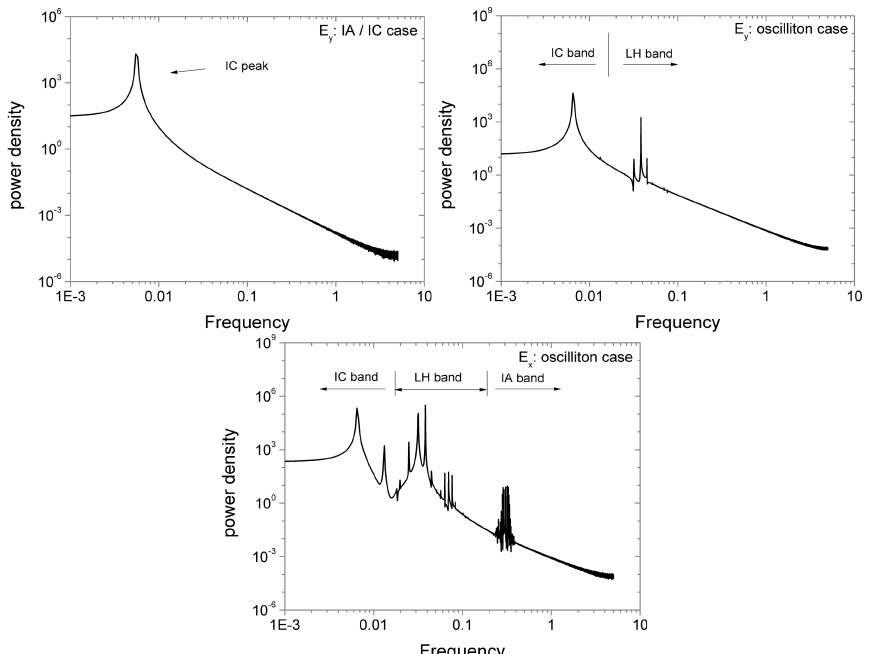
Fig. 12. FFT power spectra of socilliton structures. Upper left: E y in the IA/IC case (last subsection); upper right: E y in the oscilliton case (this subsection); lower panel: E x in the ocilliton case (this